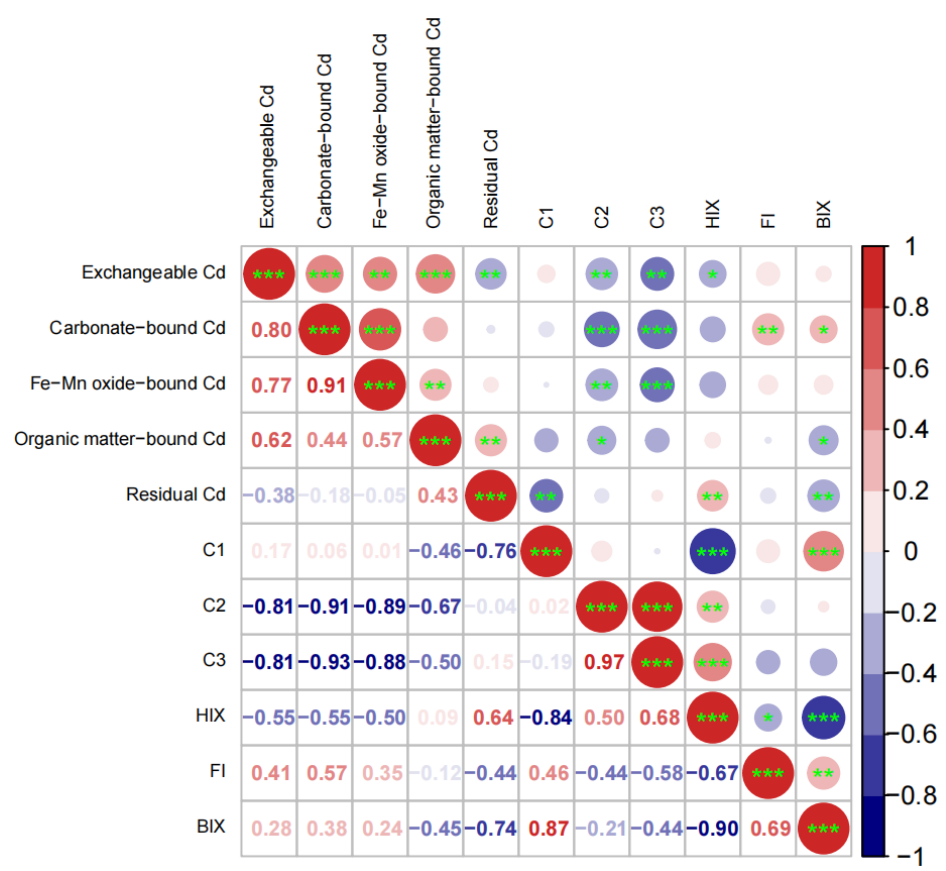
Figure 7. Correlations among the Cd chemical fractions, the intensities of fluorescent components, and the fluorescence indices (*, **, and *** represent 0.05, 0.01, and 0.001 probability level of significance, respectively).